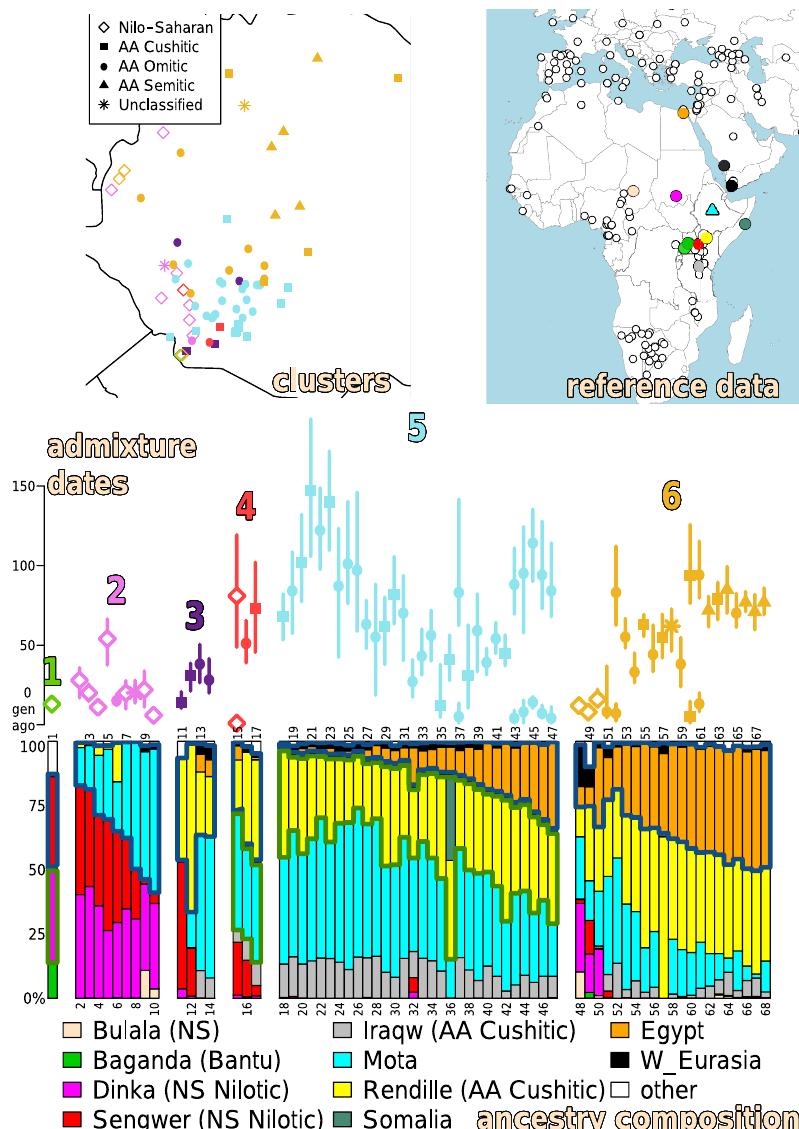
Fig. 3 Inferred ancestral composition and recent admixture events in each Ethiopian cluster. (top-left) FINESTRUCTURE-inferred genetically homogeneous clusters of Ethiopians, with location placed on the map by averaging the latitude/longitude of each cluster ’ s individuals. Colours denote which of six types of admixture event (1-6 below) each cluster falls into and symbols provide the most-represented language group among individuals ’ ethnicities in each cluster. (top-right) A subset of the 264 non-Ethiopian present-day reference populations, plus the 4.5 kya Ethiopian Mota (Gallego- Llorente et al. 4 ; cyan triangle), that DNA patterns in each Ethiopian cluster were compared to under the “ Ethiopian-external ” analysis. Filled circles (legend at bottom) indicate reference populations that contributed >5% of ancestry to at least one Ethiopian using SOURCEFIND. (Middle) Inferred admixture dates in generations from present (symbols give means and correspond to legend in the top-left panel, line = 95% CI, sample sizes given in Supplementary Fig. 12), coloured by the six types of admixture event. (Bottom) SOURCEFIND-inferred ancestry proportions for each Ethiopian cluster (key for numbers in Supplementary Data 7). Blue and green borders in the ancestry composition highlight different admixing sources. In particular we enclose the reference populations representing one of the inferred admixing sources with a thick blue line. In Ethiopian groups with >2 inferred sources, we also enclose the reference populations representing the second source with a thick green line. Using this information, we highlight six types of inferred admixture events among: (1) three sources related to the Baganda, Dinka and Sengwer, (2) two sources related to Mota and Dinka/Sengwer, (3) two sources related to Rendille and Mota or Sengwer, (4) three sources related to Rendille, Mota and Sengwer, (5) three sources related to Egypt/W.Eurasia, Rendille and Mota/ Iraqw, and (6) two sources related to Egypt/W.Eurasia and